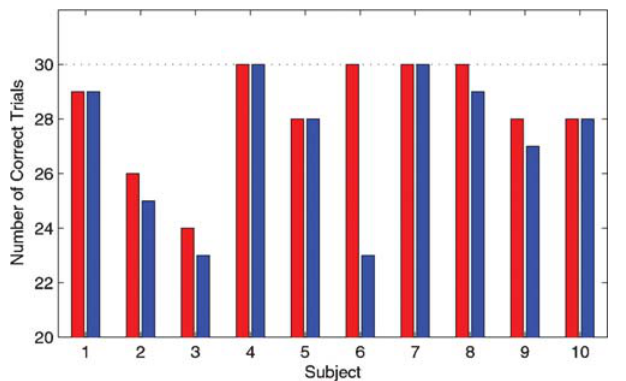
Figure 2. Melody-Variation-detection task. For each of the ten subjects, the number of correctly identified melodies (either as original or as variation) is given in red for the actively learned melodies and in blue for the passively learned melodies. The total number of trials for each case was 30. The difference between correct trials for the actively and passively learned melodies was used for a correlation analysis to evaluate familiarity effects in the functional data (see below).